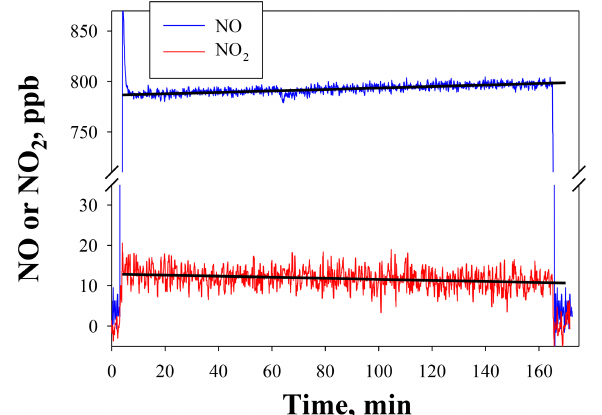
Figure 5. NO and NO 2 output by the NO calibration source over the time to use an entire 8g N 2 O cartridge. The NO set point was 800ppb. Lines drawn are linear fits to data between 15 and